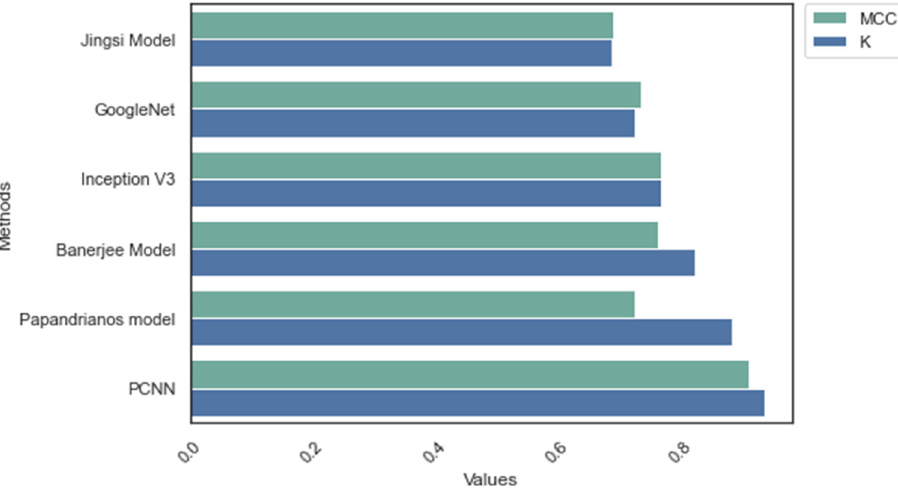
Figure 10. MCC and Kappa: Dataset_1.